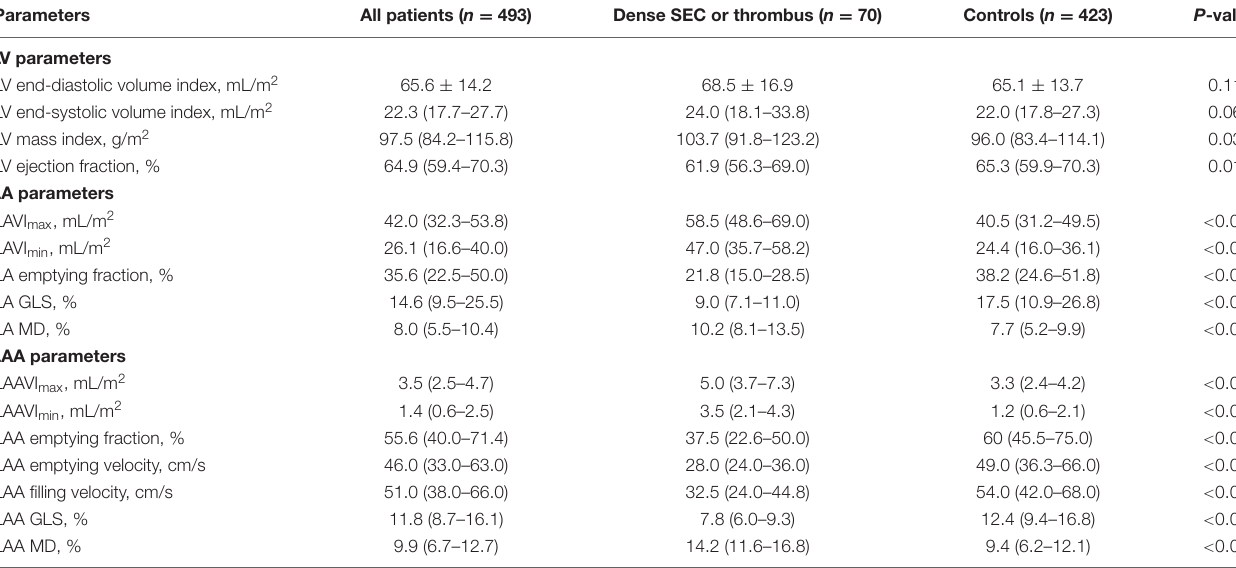
TABLE 2 | Echocardiographic parameters by groups.